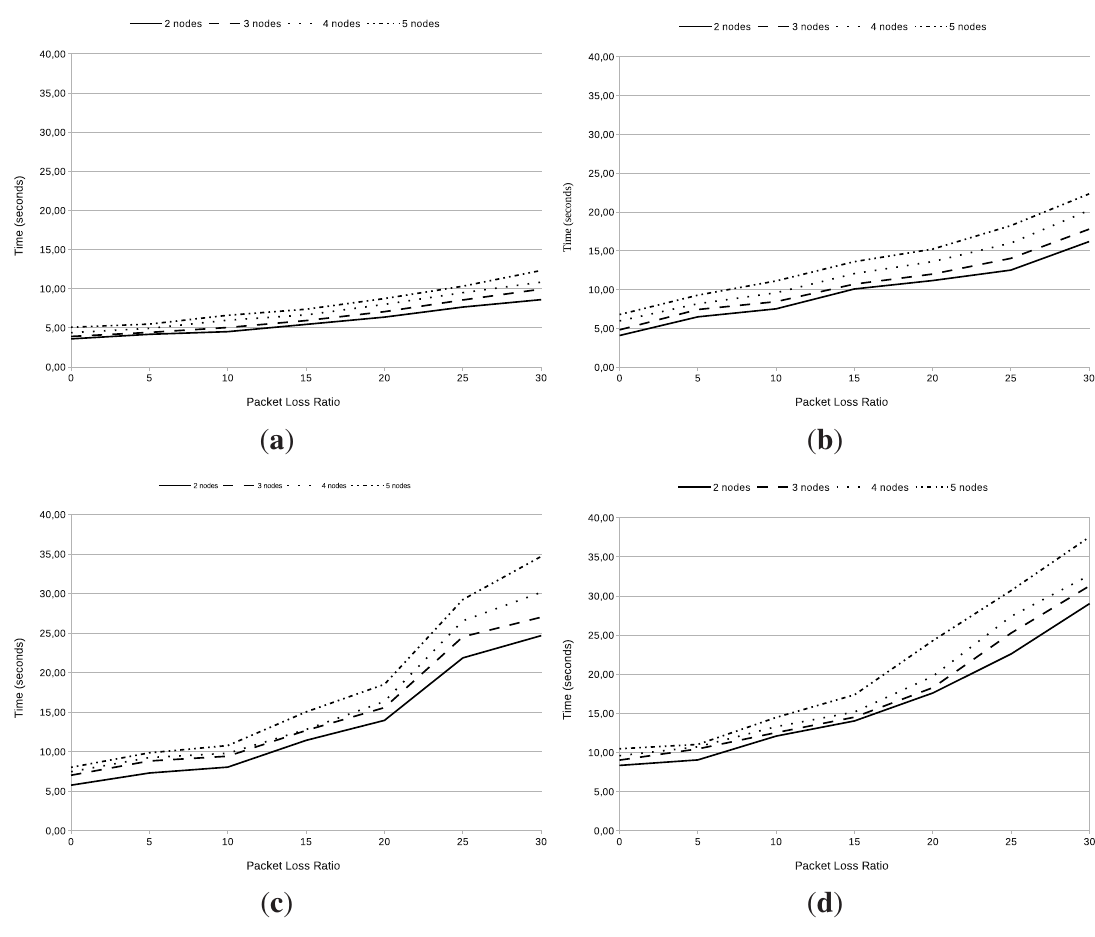
Figure 10. Execution times based on Cooja simulations. ( a ) Authentication execution time in the non-PRE scenario; ( b ) re-authentication execution time in the non-PRE scenario; ( c ) authentication execution time in the with-PRE scenario; ( d ) re-authentication execution time in the with-PRE